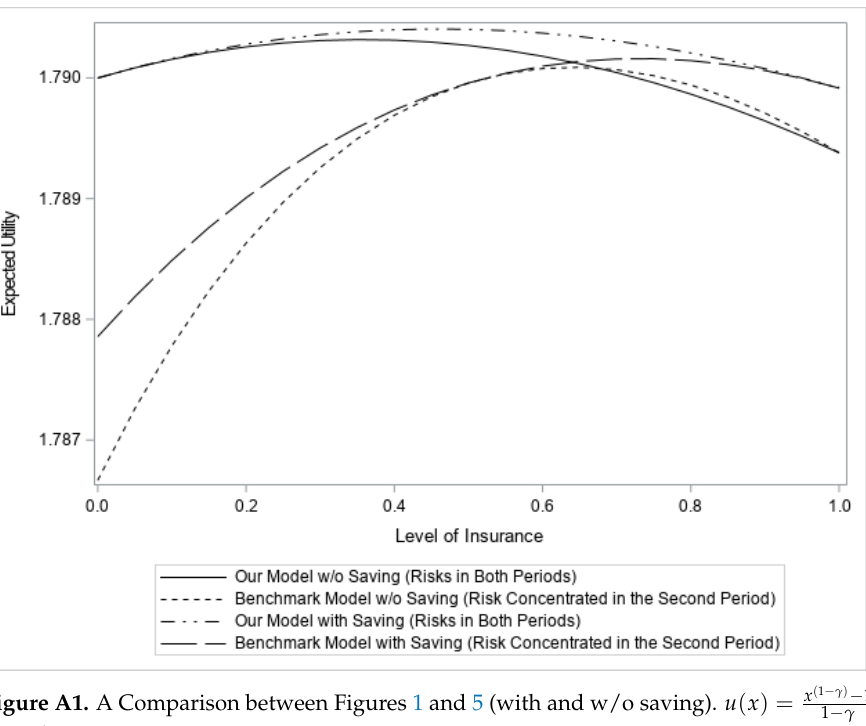
Figure A1. A Comparison between Figures 1 and 5 (with and w/o saving). u ( x ) = x ( 1 − γ ) − 1 L = 2 l = 4; q = π = δ = 0.2; λ = 0.2; γ =